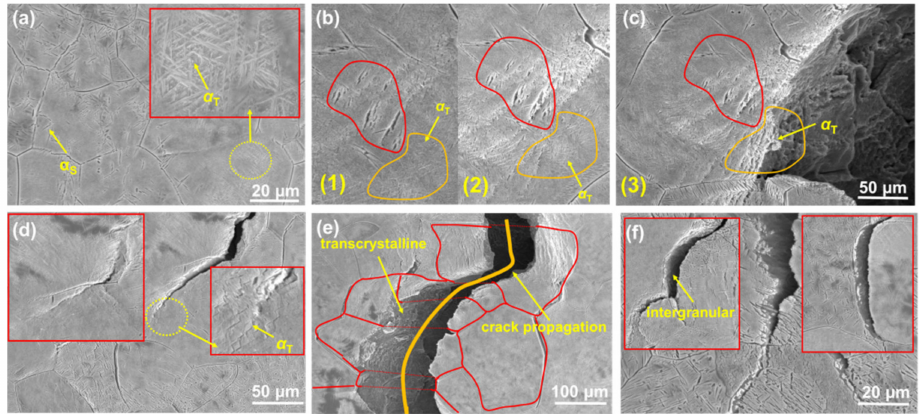
Figure 12. In situ tensile testing process of HLDA alloy ( a ) ε = 0.10, ( b ) ε = 0.26, ( c ) ε = 0.34, ( d ) ε = 0.41, ( e ) ε = 0.53, ( f ) ε =